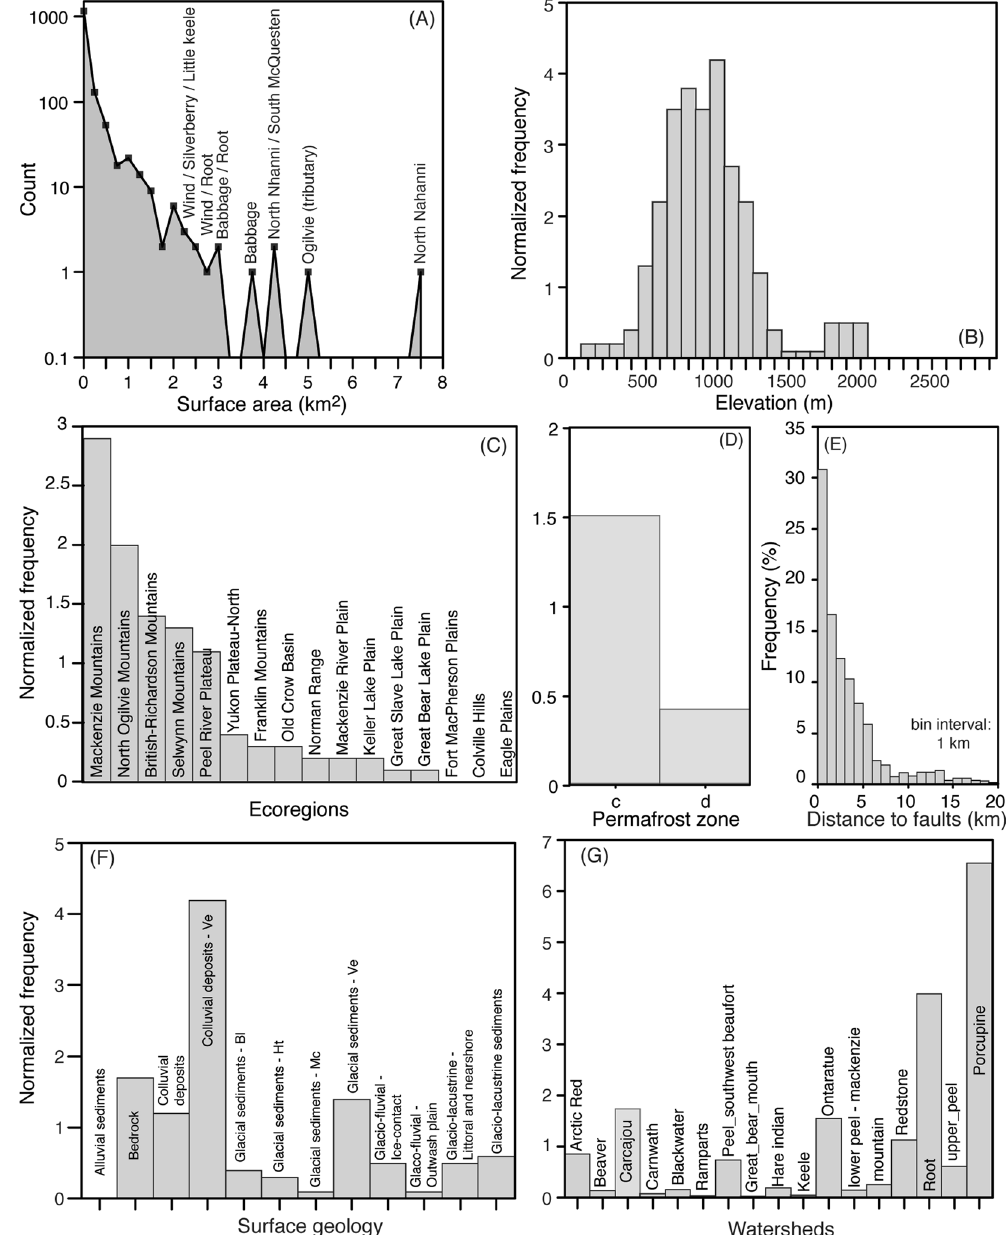
Figure 2. Frequency distribution of mapped icings in northwestern Canada . (A ) Surface area of icings. ( B ) Histogram showing the normalized frequency distribution of icings with respect to elevation in study area in 100 m elevation bins. ( C ) Histogram showing the normalized frequency distribution of icings with respect to ecoregions. ( D ) Histogram showing the normalized frequency distribution of icings with respect to permafrost zones (c = continuous; d = discontinuous). ( E ) Histogram showing the distance between icings and the closest geological fault in 1 km bin interval. ( F ) Histogram showing the normalized frequency distribution of icings with respect to surficial geology. ( G ) Histogram showing the normalized frequency distribution of icings with respect to